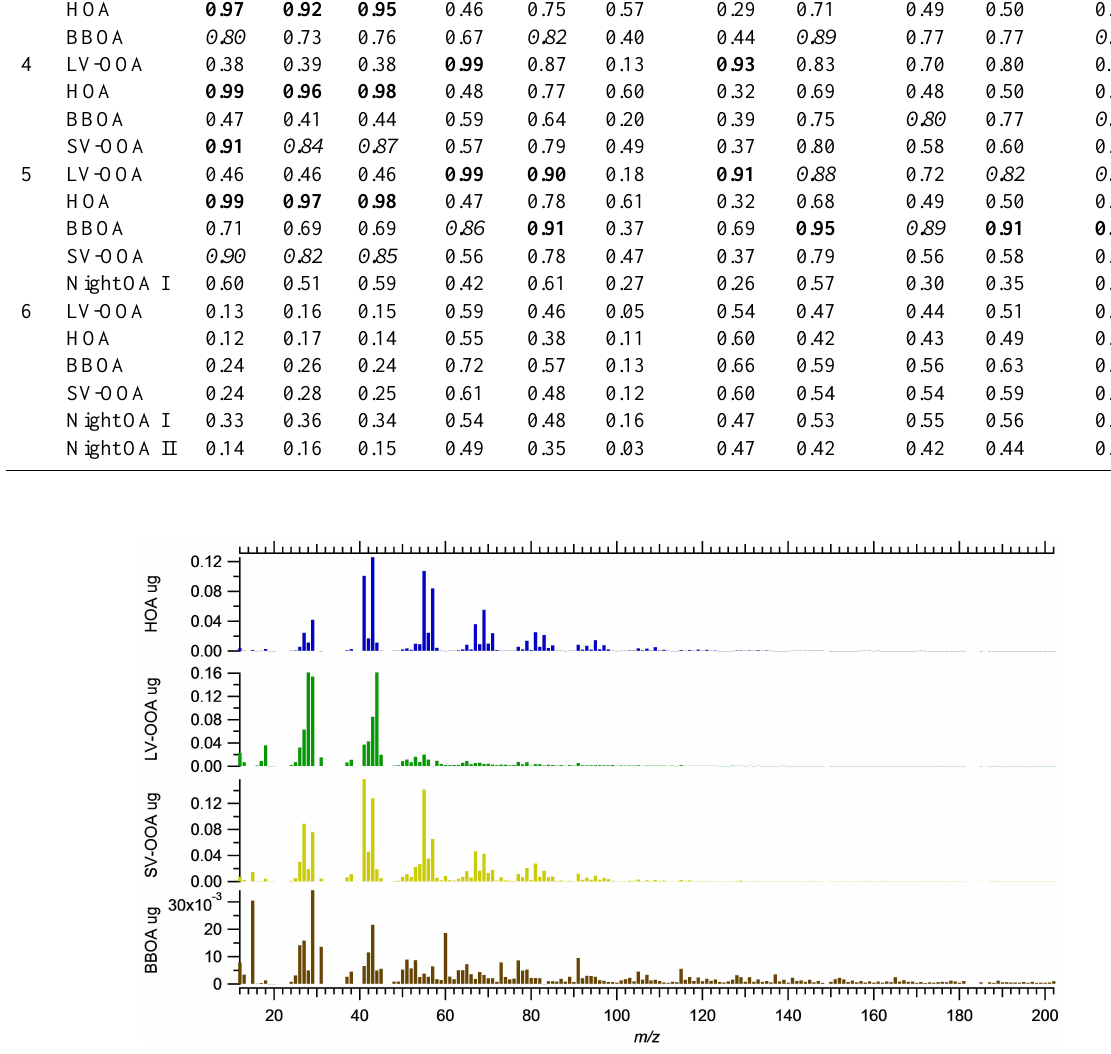
Fig. 6. PMF factor profiles through m/z 200 for the four-factor